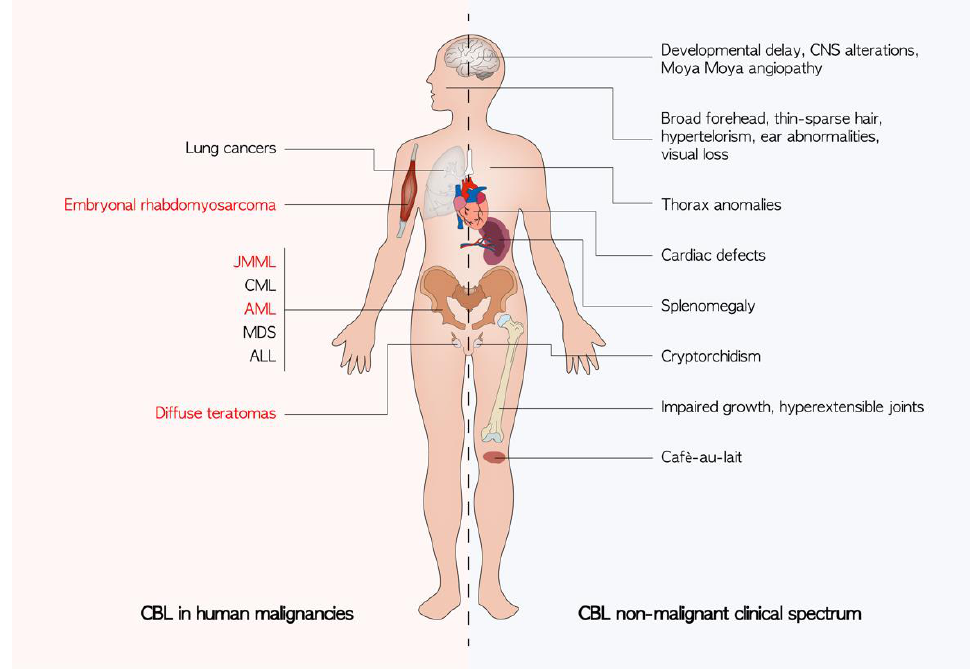
Figure 3. Known clinical manifestations of CBL mutations. The non-malignant phenotypes are an expression of germline CBL mutations. Cancers described in patients harboring a germline CBL mutation are highlighted in red. ALL: acute lymphoblastic leukemia; AML: acute myeloid leukemia; CML: chronic myelomonocytic leukemia; CNS: central nervous system; JMML: juvenile myelomonocytic leukemia; MDS: myelodisplastic syndrome.